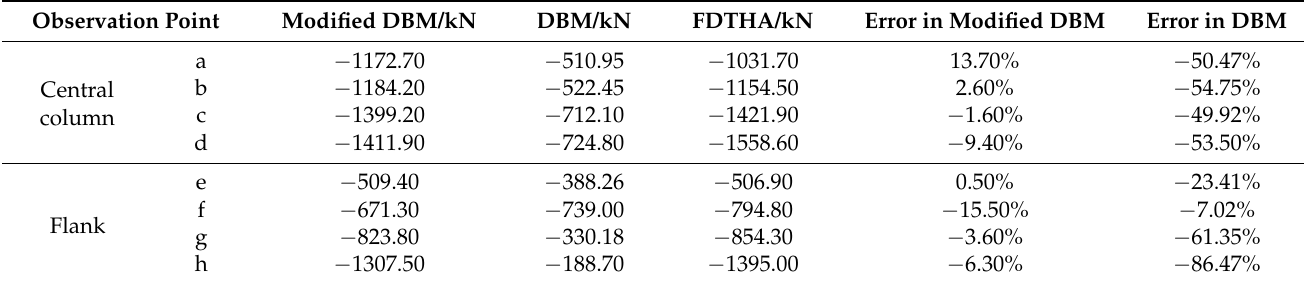
Table 6. Comparison of axial force predicted by the modified